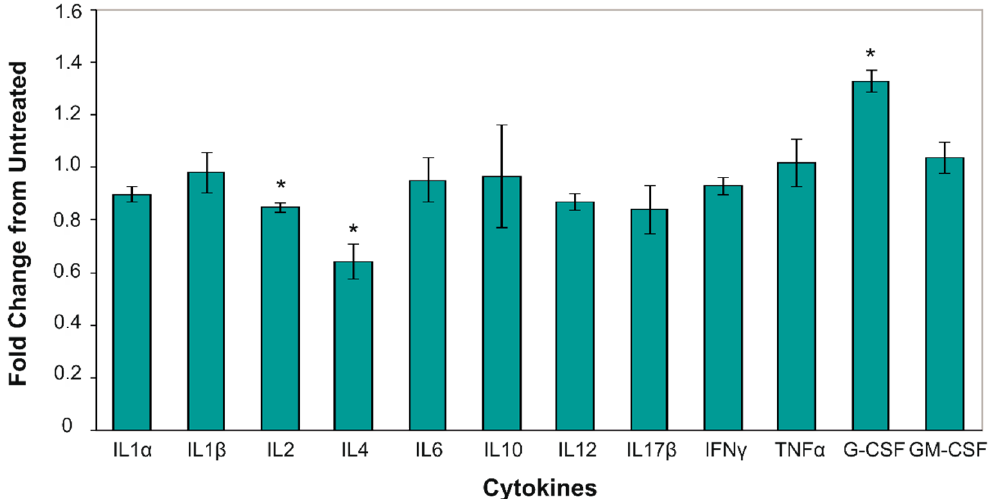
Figure 6. Cytokine levels in the blood serum of CAP-treated mice. The relative blood cytokine level in the CAP-irradiated mice serum. Data were normalized to the non-treated control and presented as the mean ± SEM ( n = 5). Blood samples were collected on day 12, 1 h after the second CAP irradiation. The differences were calculated using the Student’s t-test, the difference between groups was statistically significant at p < 0.05 (*).